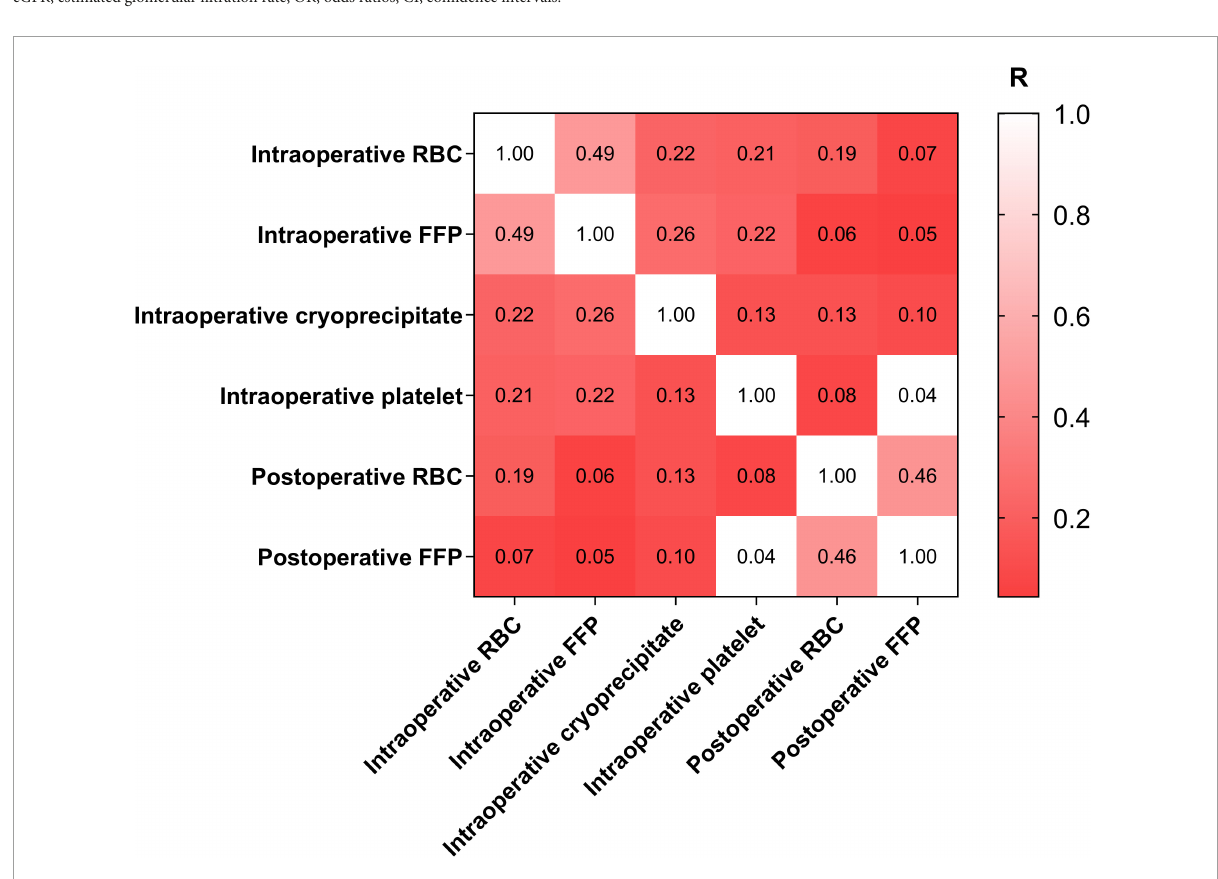
FIGURE2 Correlations of different blood products. RBC, red blood cell; FFP, fresh frozen